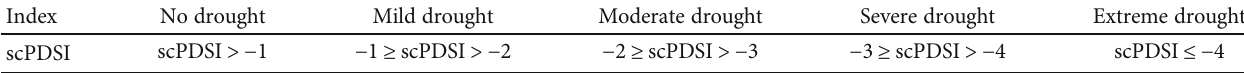
Table 2: scPDSI categories [29].